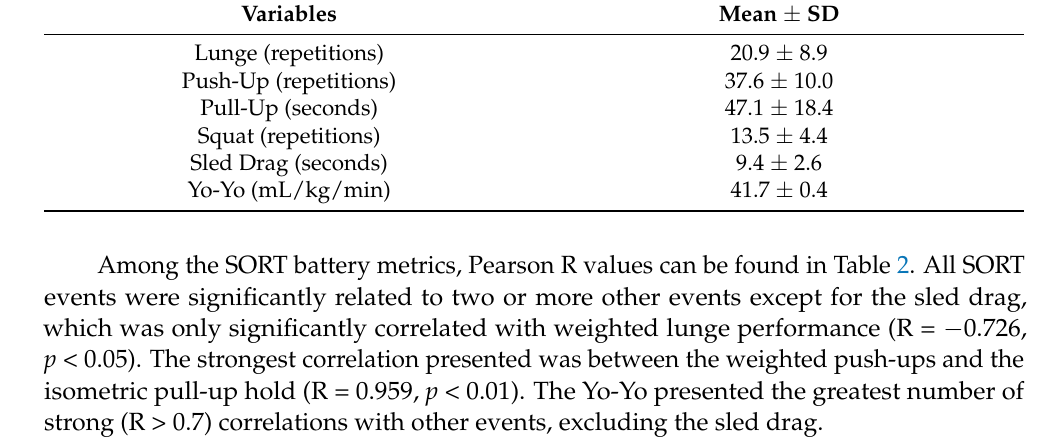
Table 2. Pearson Correlation Coefficient values between SORT events ( n = 14). Lunge Push-Up Pull-Up Squat Sled Yo-Yo Lunge 1.00 0.638 * 0.601 0.802 ** − 0.726 * 0.894 ** Push-Up 0.639 * 1.00 0.959 ** 0.769 ** − 0.041 0.790 ** Pull-Up 0.601 0.959 ** 1.00 0.684 * − 0.024 0.769 ** Squat 0.802 ** 0.769 ** 0.684 * 1.00 − 0.363 − 0.803 ** Sled − 0.726 * − 0.041 − 0.024 − 0.363 1.00 − 0.537 Yo-Yo 0.894 ** 0.790** 0.769 ** 0.803 ** −